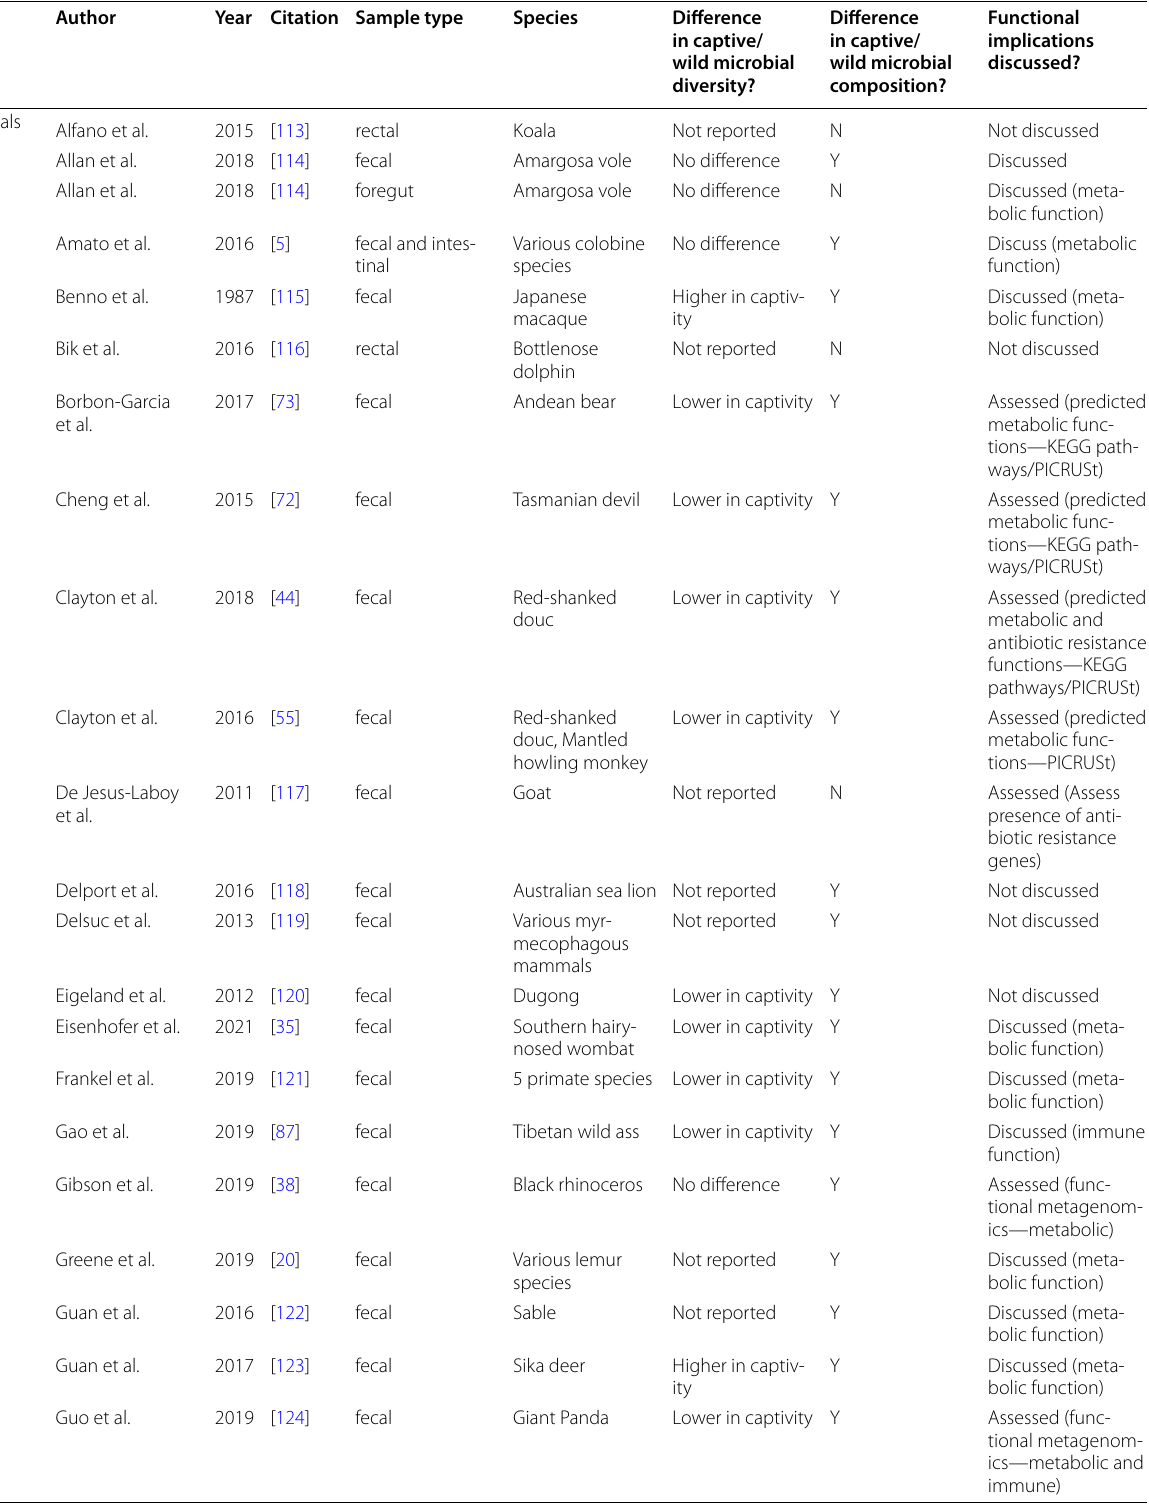
Table 1 Papers comparing the gut microbiomes of captive animals and their wild